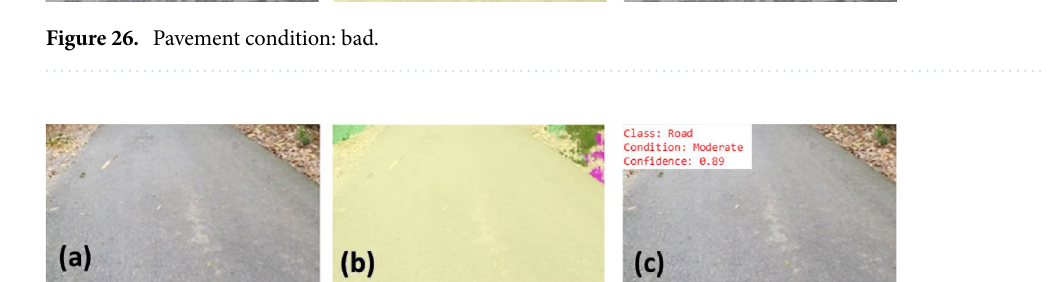
Figure 27. Pavement condition: moderate.